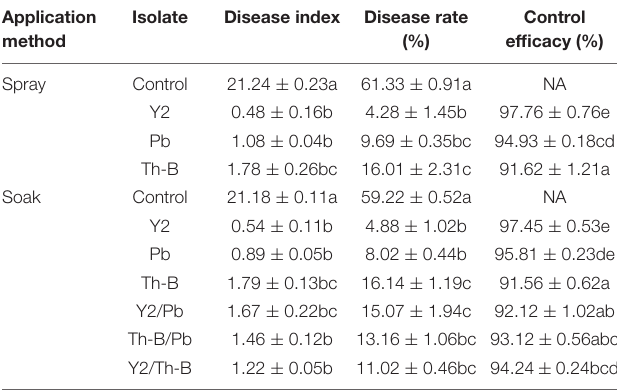
TABLE 1 | Effect of various concentrations of five treatments on tobacco mildew disease. TABLE 2 | Effect of different application methods on tobacco